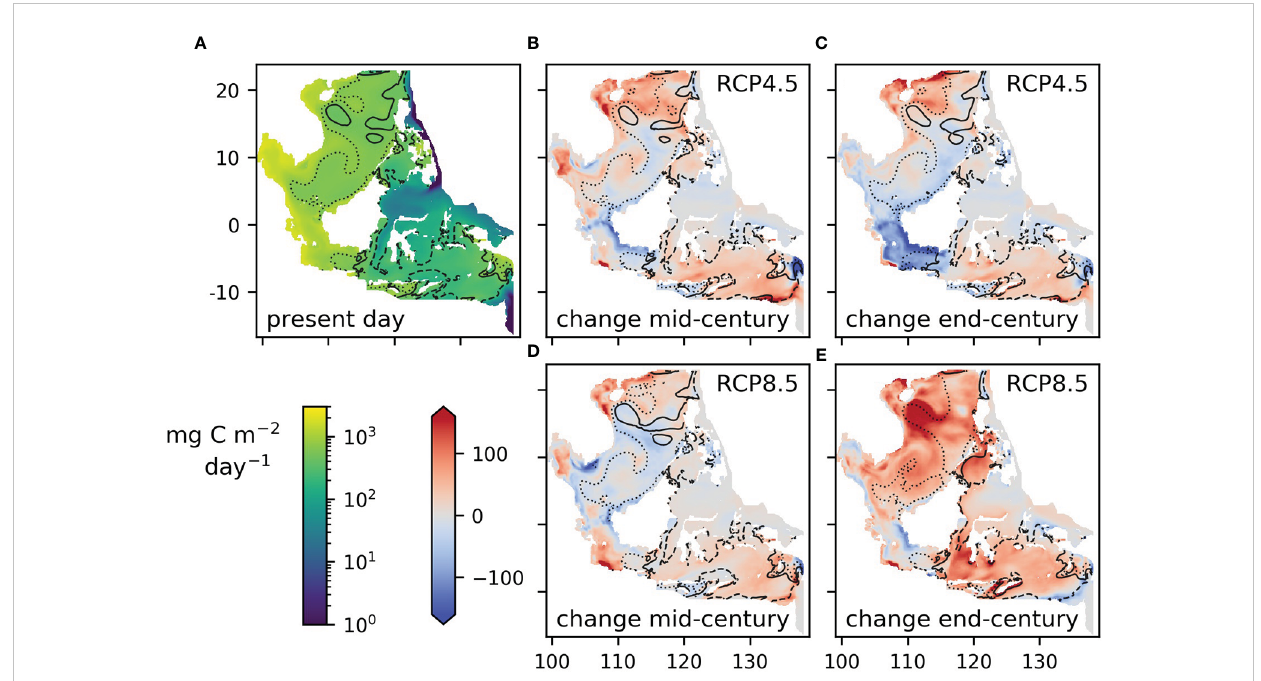
FIGURE 6 Column total net primary production: (A) mean for the present day (2000-2019), (B, D) difference between the mid-century (2040-2059) mean and the 2000-2019 mean under RCP4.5 and RCP8.5, (C, E) difference between the end-century (2079-2098) mean and the 2000-2019 mean under RCP4.5 and RCP8.5. The solid black contour shows the median for the present day, the dashed line the 25th quartile and the dotted line the 75th